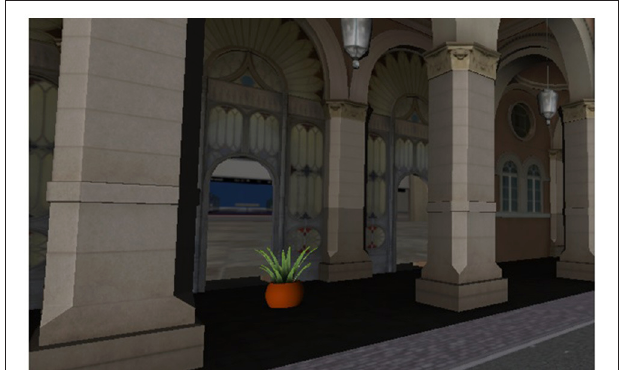
FIGURE 3 | One of the objects to be found during the VR-based training program. During the encoding phase, participants were asked to locate one, two or three hidden objects (i.e., a bottle of milk, a plant in a vase and a trunk). They received the specific instruction of memorizing the position of these objects, which were positioned at different parts of the city since in the retrieval phase they were asked to retrieve their spatial positions. The training was personalized according to the level reached by each participant, so that if a patient was not able to locate the first object, the other objects were not presented.